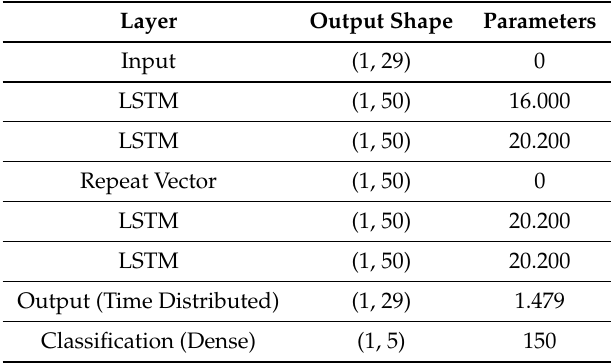
Table 2. Five-class Wind Status Classification LSTM-SAE